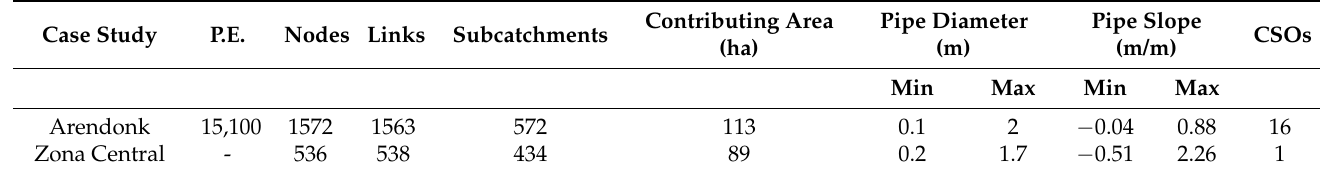
Table 1. Summary of characteristics of the selected case-study catchments, including population equivalents